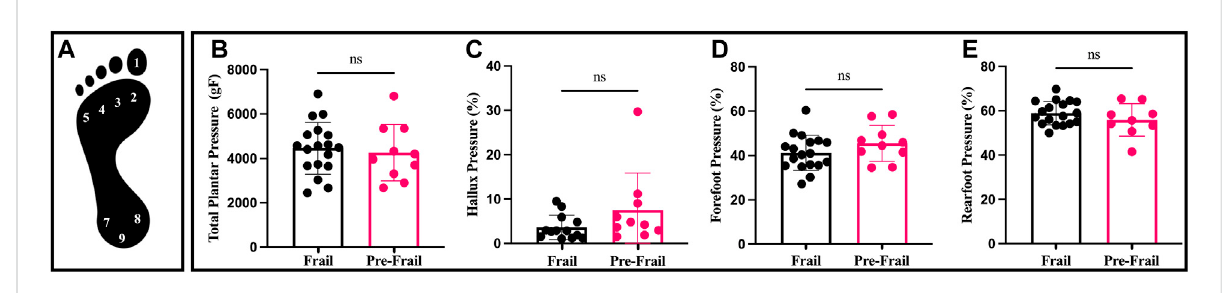
FIGURE 1 Plantar pressure and distribution; (A) sensors location on foot; (B) total plantar pressure; (C) percentage (%) of hallux pressure by total plantar pressure; (D) percentage (%) of forefoot pressure by total plantar pressure; (E) percentage (%) of rearfoot pressure by total plantar pressure. ns: non- signi fi cant.